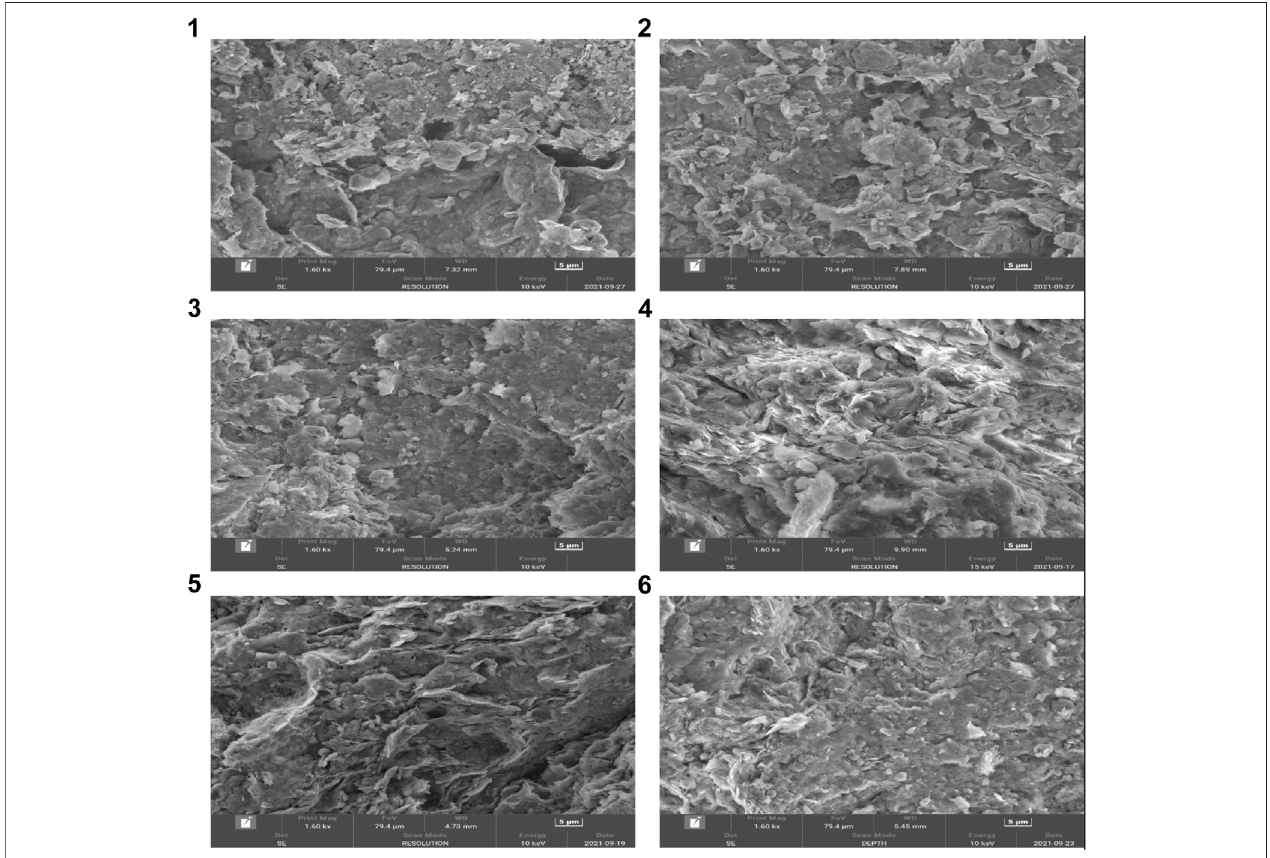
FIGURE 4 | SEM imaging of improved expansive soil, 1,600x. (A) p = 0, (B) p = 50 kPa, (C) = 100 kPa, (D) p = 200 kPa, (E) p = 400 kPa, (F) p = 800 kPa.